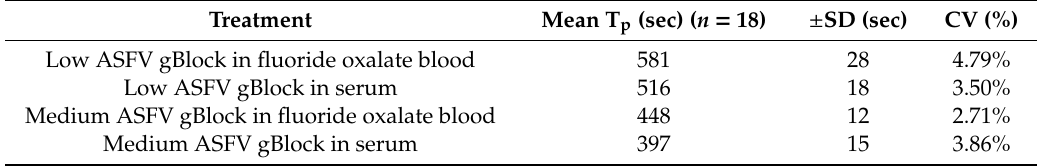
Table 4. Assessment of inter-run variation of ASFV LAMP assay and coe ffi cient of variation.